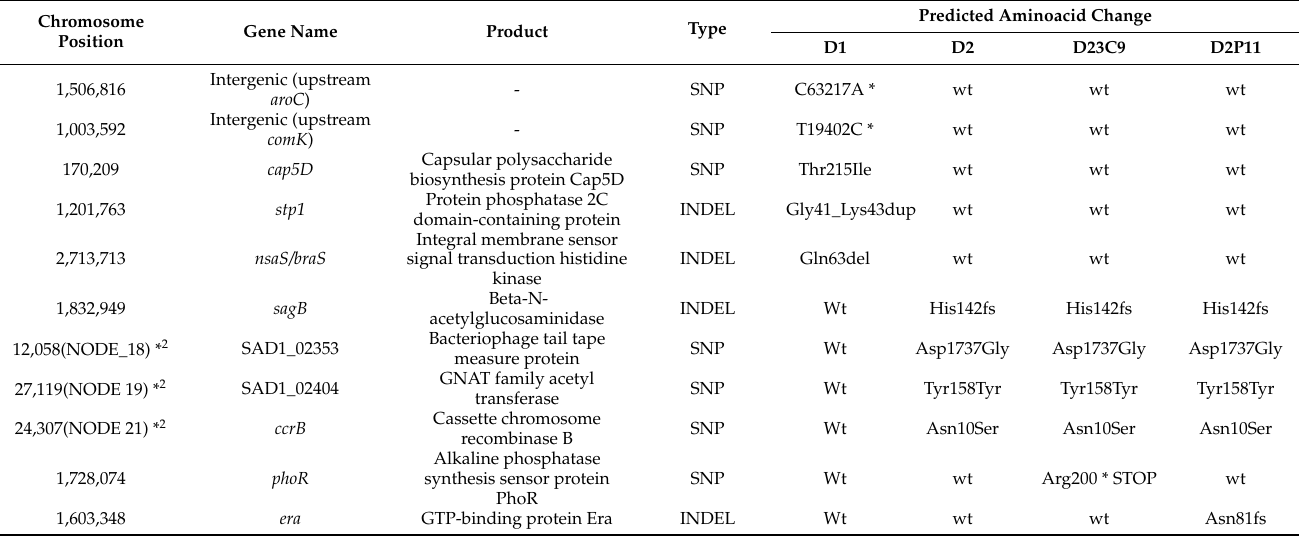
Table 5. Genetic changes differing between strains analyzed in this study after mapping the reads to the S. aureus D1 genome. All changes and positions are expressed in reference to the S. aureus N315 reference genome except otherwise stated. Genes without an annotated name are in reference to the CDS of N315 (or D1 genome if not present in the latter) by their locus